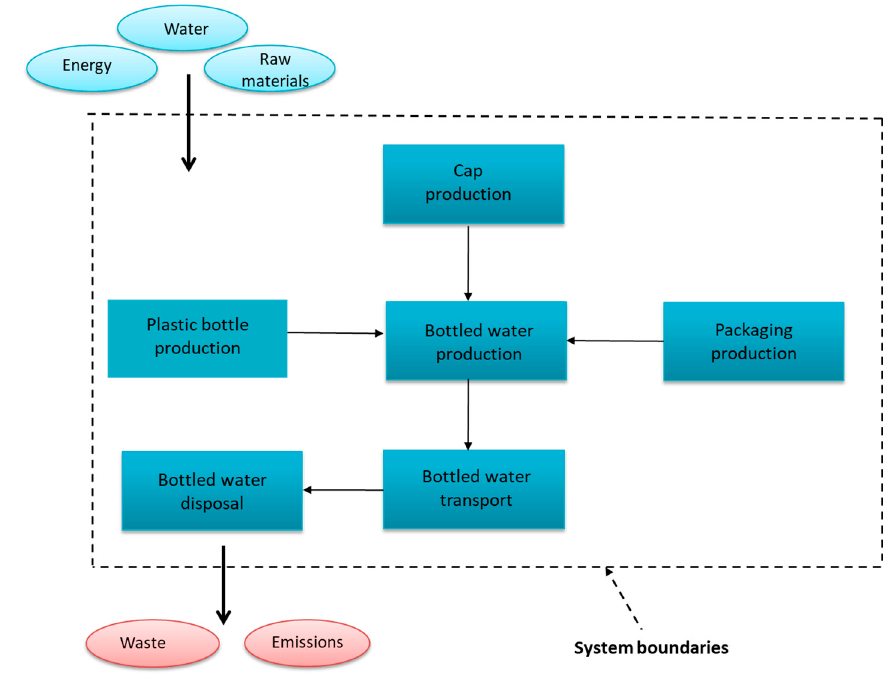
Figure 3. System boundaries of the use of bottled